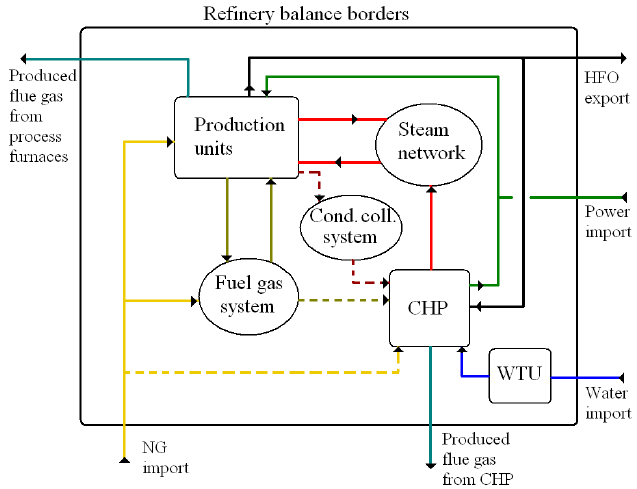
Figure 1. Schematic depiction of refinery superstructure. CHP = combined heat and power unit; Cond. coll. = steam condensates collection; HFO = heavy fuel oil; NG = natural gas; WTU = water treatment unit.